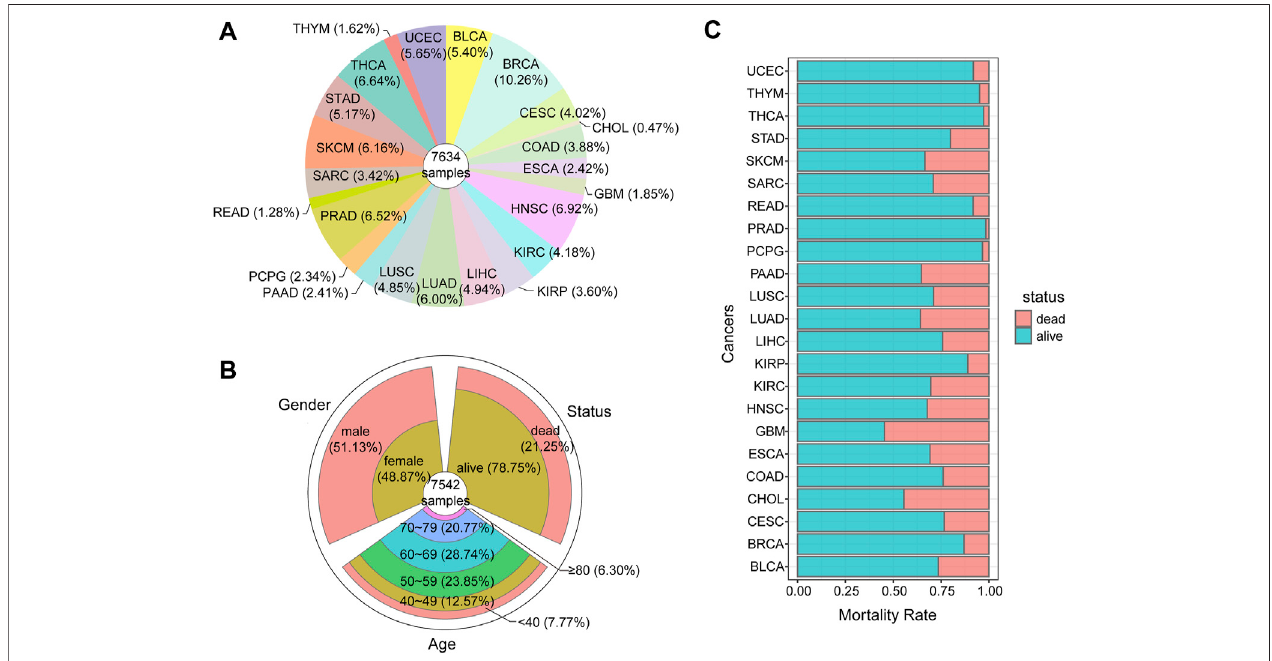
FIGURE 2 | Characteristics of pan-cancer tumor samples (A) The proportion ofsamples collected for each cancer (B) The clinical information oftumor samples (C) The mortality rate of each cancer.